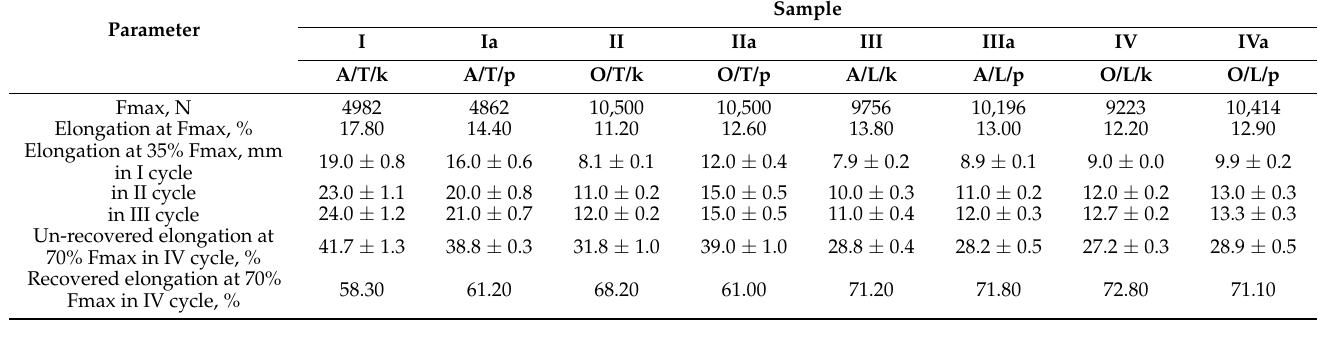
Table 4. Summary of test results of mechanical properties of the woven.